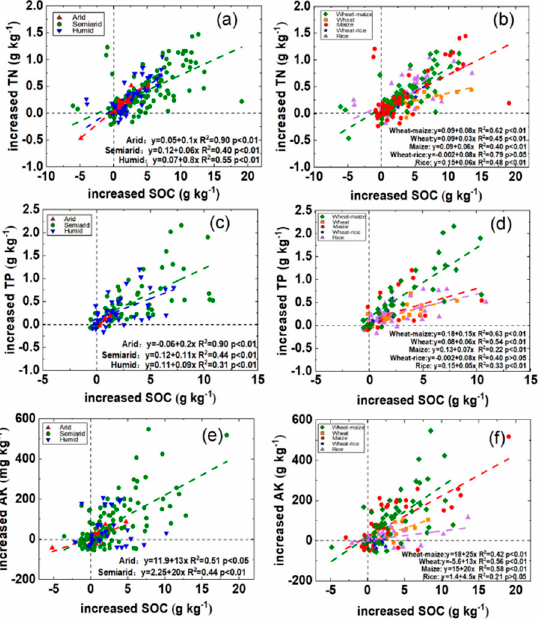
Figure 9. Interactions between the increased SOC and increased TN ( a , b ), increased SOC and increased TP ( c , d ) and increased SOC and increased AK ( e , f ) depending on regions with different HIs (humidity index) (HI = MAP/(MAT + 10)) and crops (wheat − maize, wheat, maize, wheat − rice , rice). SOC: soil organic carbon. TN: total nitrogen. TP: total phosphorus. AK: available potassium. HI ≤ 25: arid region, 25 < HI < 50: semiarid region, HI ≥ 50: humid region. The horizontal dotted line indicates y = 0 and the vertical dotted line indicates x = 0. The dashed lines reflect the linear regressions. MAT: mean annual temperature, MAP: mean annual precipitation.